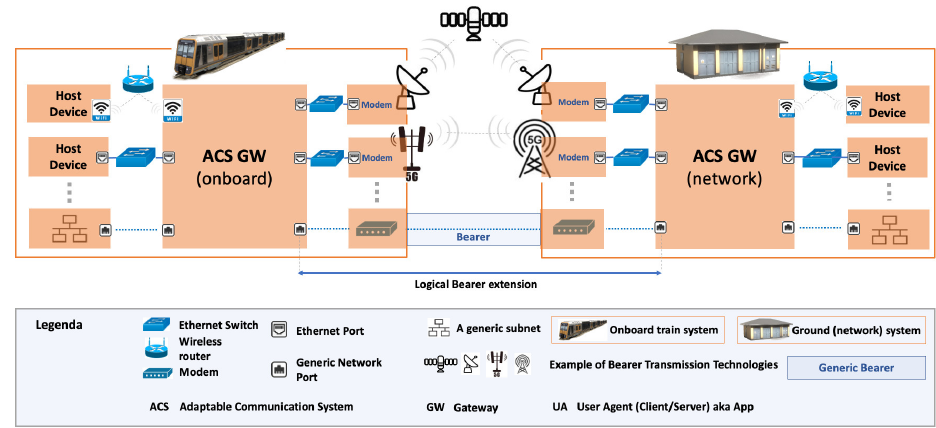
Figure 2. ACS Conceptual